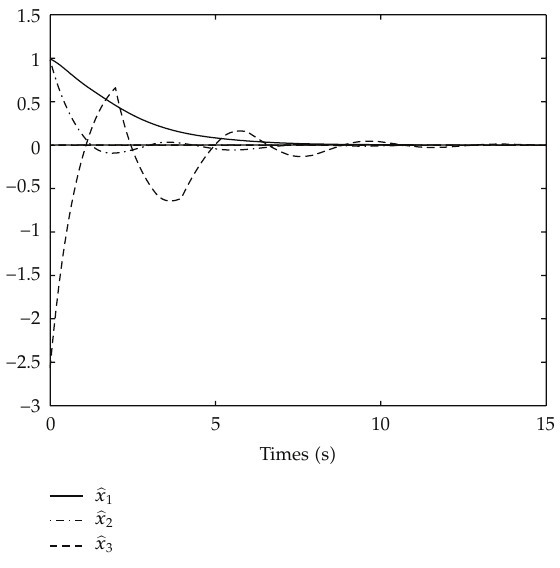
Figure 2: State responses (cid:11) x (cid:2) t (cid:3) of the filter